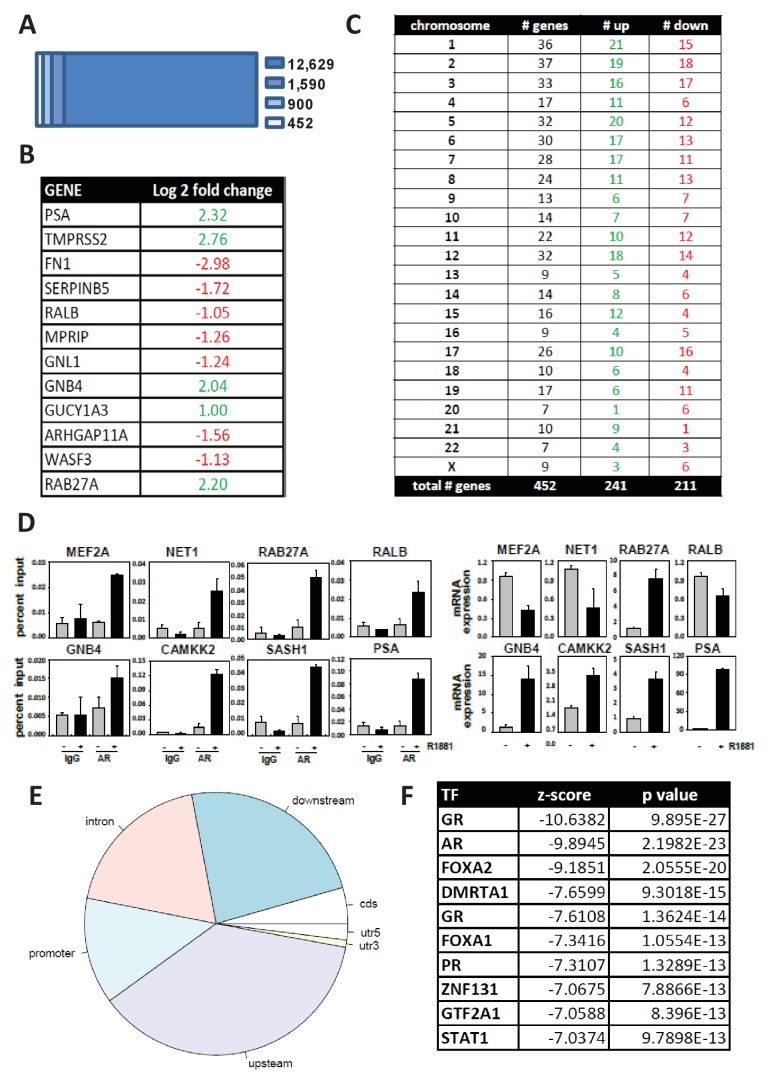
Isolation and validation of a 452 AR target gene signature.(A) 1590 of 12,629 genome-wide ARBS sites in LNCaP cells are present within 300 Kb of the TSSs of 900 androgen-responsive genes. Of these 900 genes, 452 had at least a 2-fold change in expression upon exposure of LNCaP cells to 5 nM of the synthetic androgen R1881 for 48 hr, as determined using a custom Agilent gene expression oligoarray. (B) Representative sample of 452 AR target genes. Log fold change indicates the level of androgen regulation. Fold change represent mean value obtained from biological triplicates. Green, androgen-induced gene; red, androgen-repressed gene. (C) Overview of chromosomal distribution of 452 AR target genes. Green, number of androgen-induced genes; red, number of androgen-repressed genes. (D) ChIP validation of androgen-dependent recruitment of AR to the predicted AREs within AR target genes (left panel). Real-time RT-PCR validation of androgen dependent changes in corresponding gene expression (right panel). Results reflect the effect of 16 hr treatment with 5nM R1881. (E) Genomic location of ARBSs within the 452 AR target genes. (F) Cistrome identification of 10 most significantly enriched TF binding sites in ARBSs of the 452 AR target genes, with corresponding z-scores and p values. The 2 GR entries reflect different consensus binding motifs.